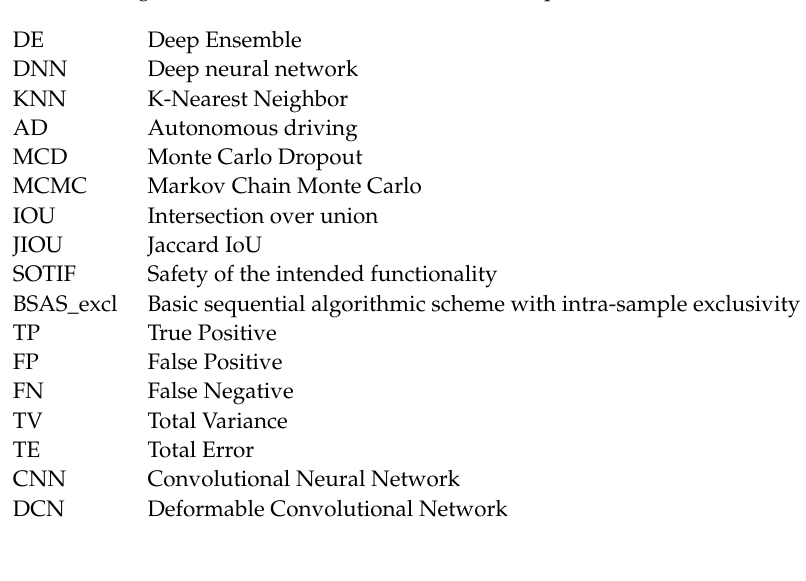
Basic sequential algorithmic scheme with intra-sample